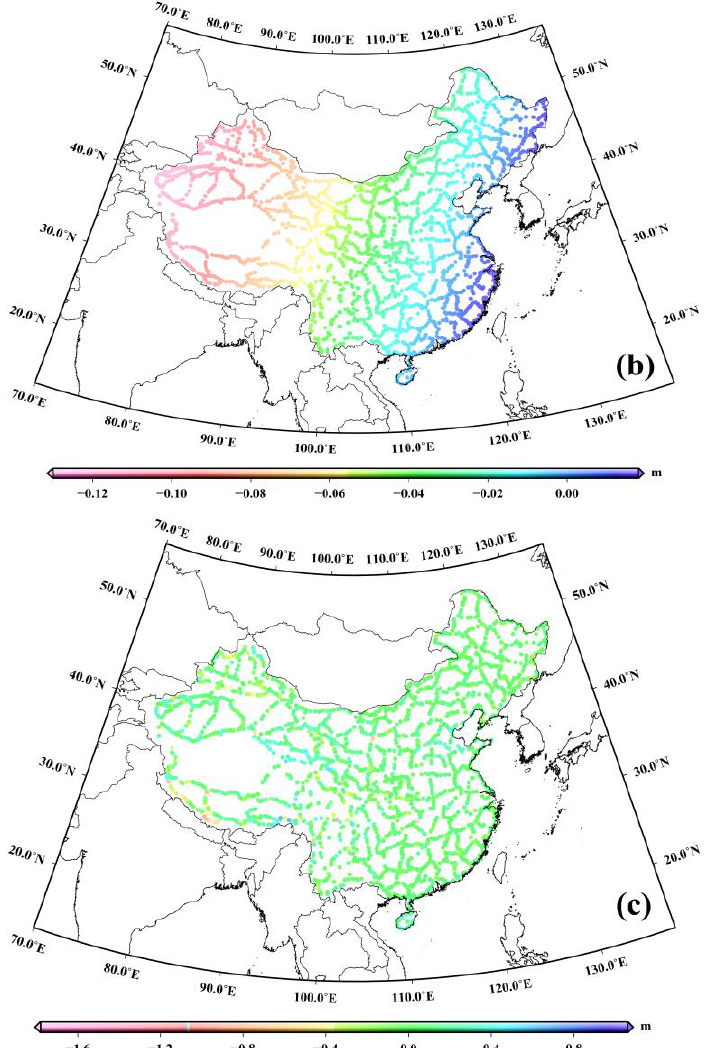
Figure 10. ( a ) Vertical offsets distribution without applying planar correction surface, ( b ) correction surface at GNSS-leveling stations, and ( c ) vertical offsets distribution after applying the planar correction. Table 5. Statistics of the without-planar corrections and with-planar corrections scenarios for the